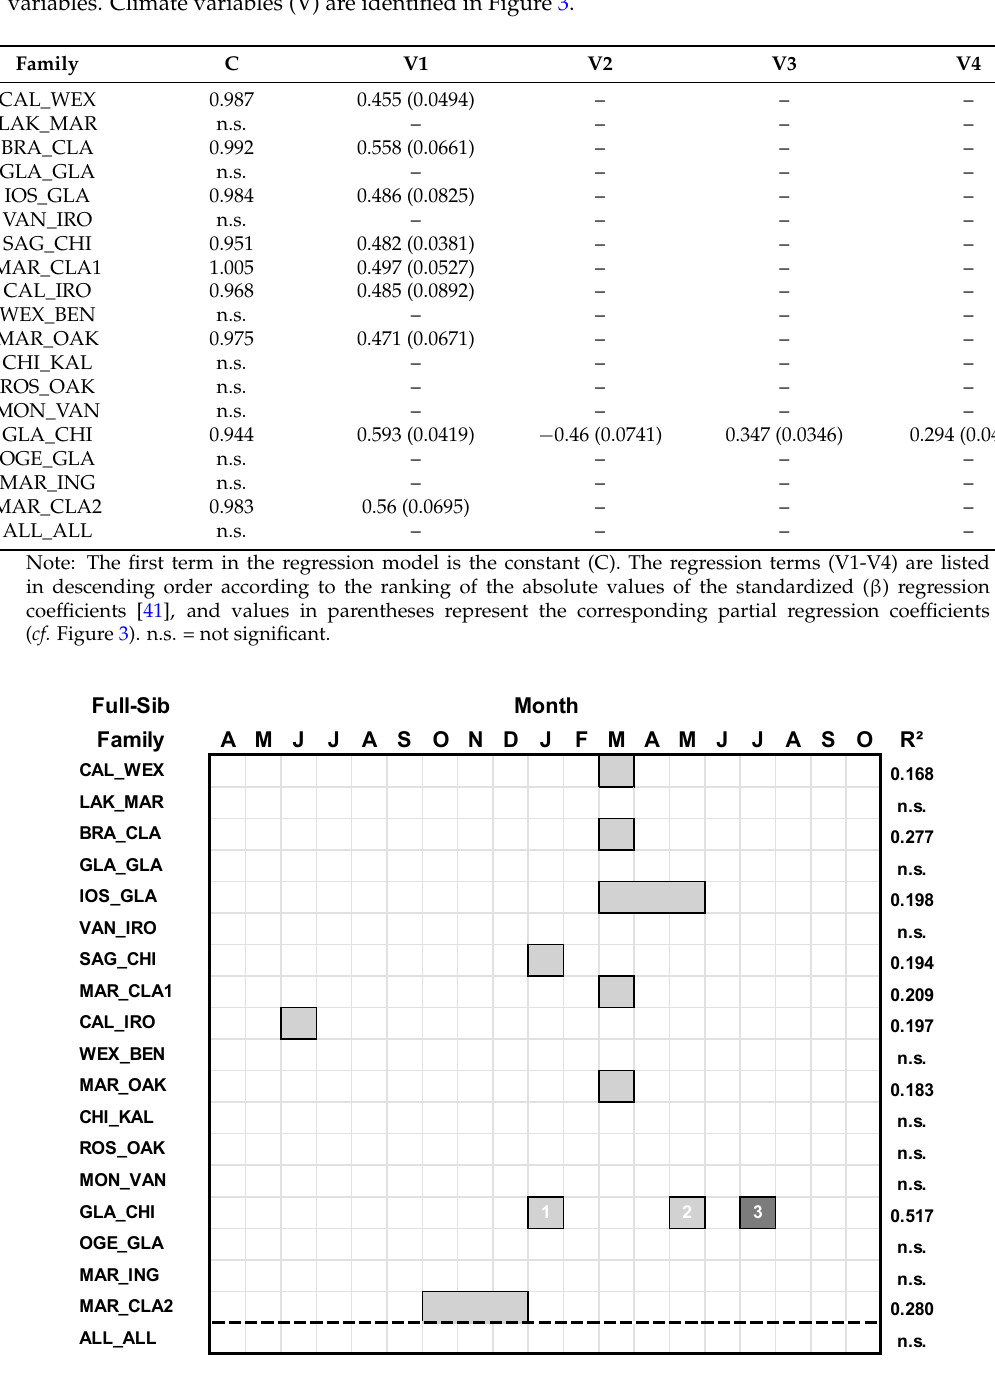
Figure 3. Regression models between Basal Area Index (BAI) and temperature variables for each family of hybrid aspen and all families combined. Climate variables spanned April of the prior year (t-1) to October of the current year(t)). For each regression model, predictor climate variables having a positive relationship with growth are denoted by light gray boxes, and predictor climate variables having a negative relationship with growth are denoted by darker gray. The numbers within the boxes denote the ranking of the climate variables according to their standardized regression ( β ) coefficient (highest = rank 1).